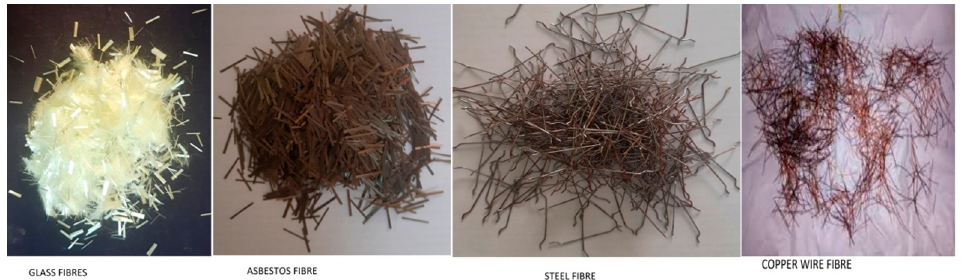
Figure 1. Types of fibers [23].